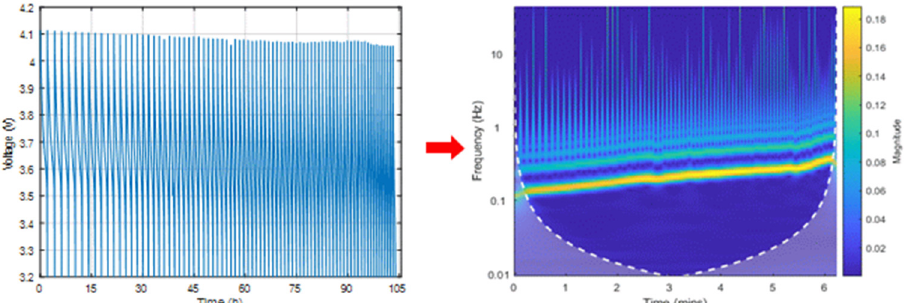
Figure 4. Result of CWT of reference discharge-RW09.